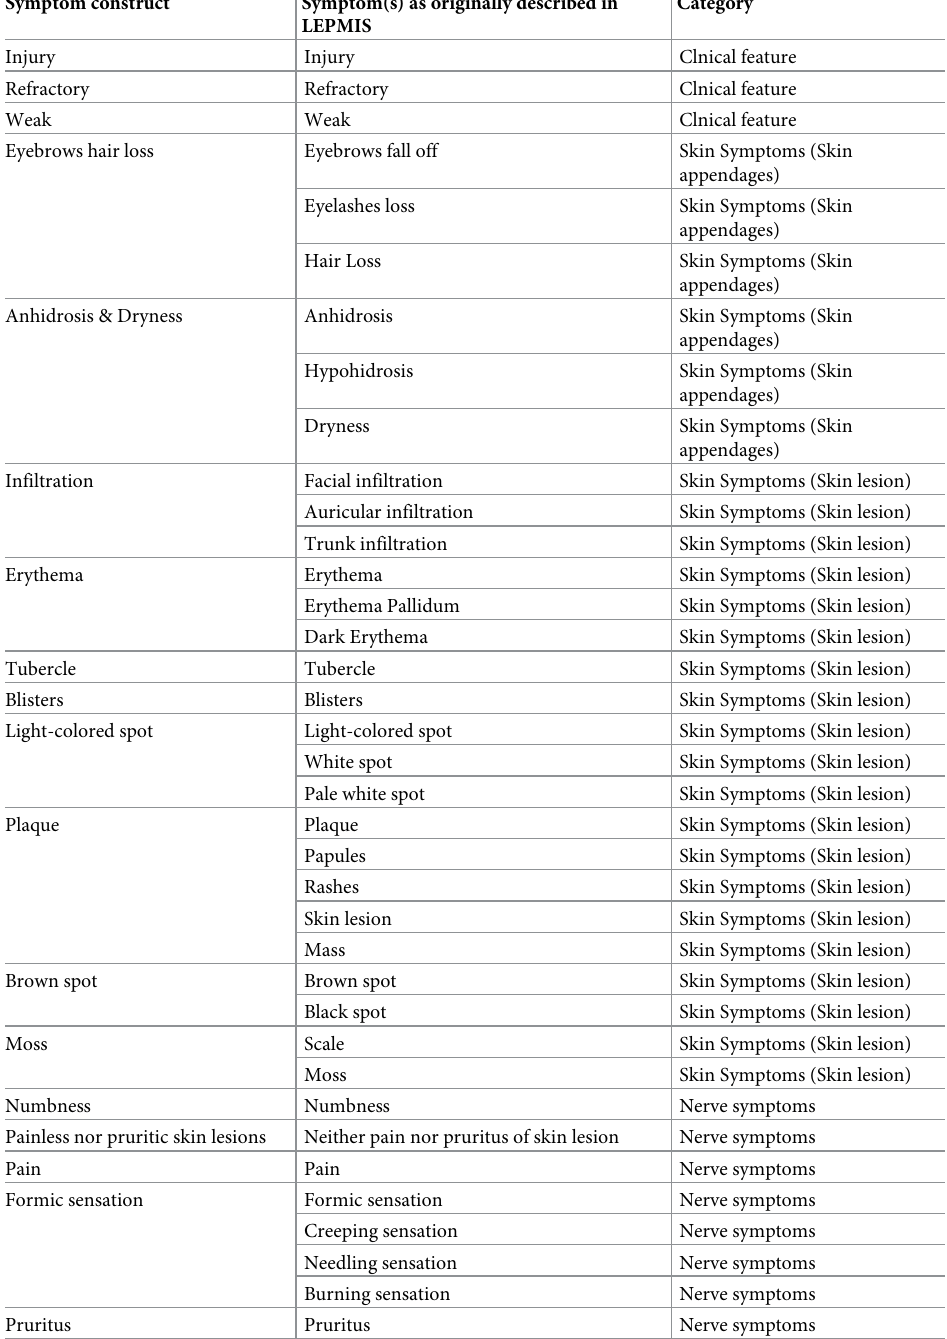
Table 2. The defined symptoms of interest as derived from those described in the LEPMIS in Yunnan, China